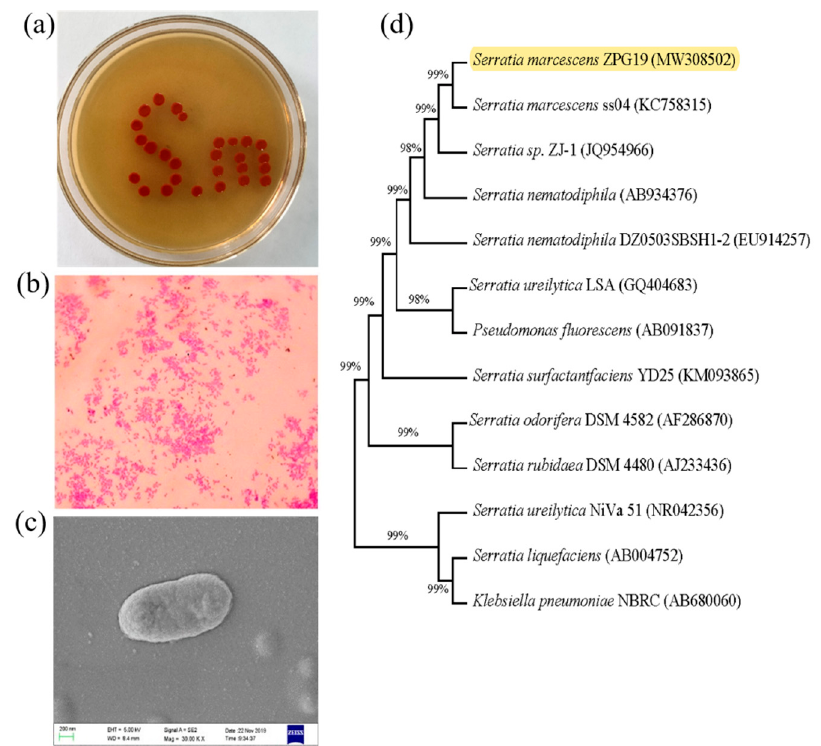
Figure 2. Phenotypic characteristics of Serratia marcescens ZPG19. ( a ) Colony morphology, ( b ) Gram staining, ( c ) scanning electron microphotograph (magnification, 300,000 × ). ( d ) Neighbor-joining phylogenetic tree based on 16S rRNA gene sequences of S. marcescens ZPG19 and closely related strains. The accession numbers of the sequences are indicated in brackets after the strain names.